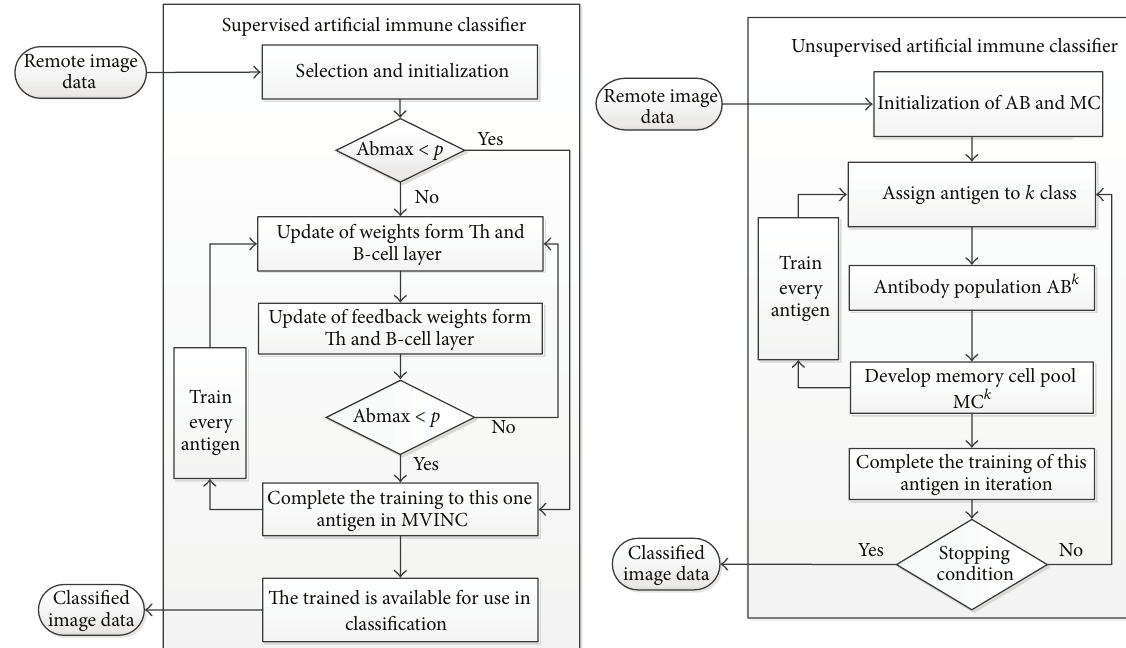
Figure 1: Artificial immune classifiers with supervised-unsupervised learning models [2,